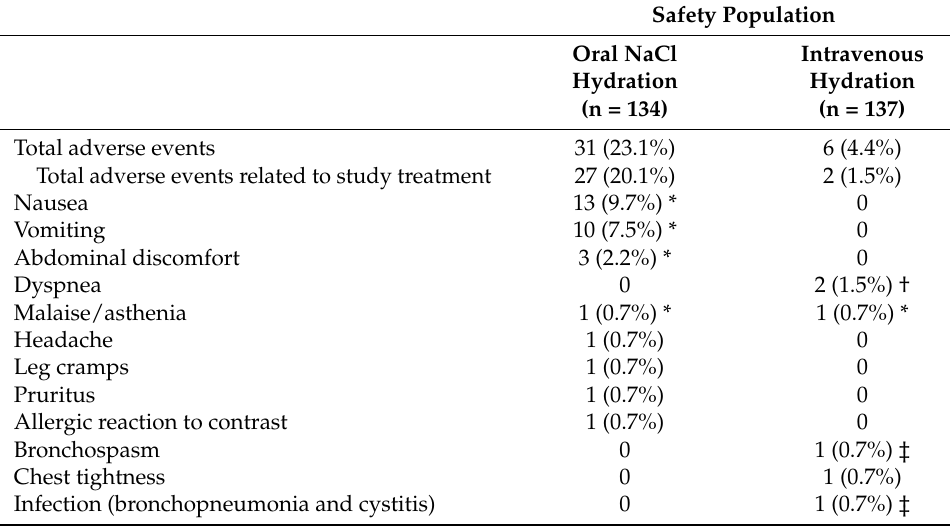
Table 3. Safety analysis: Adverse